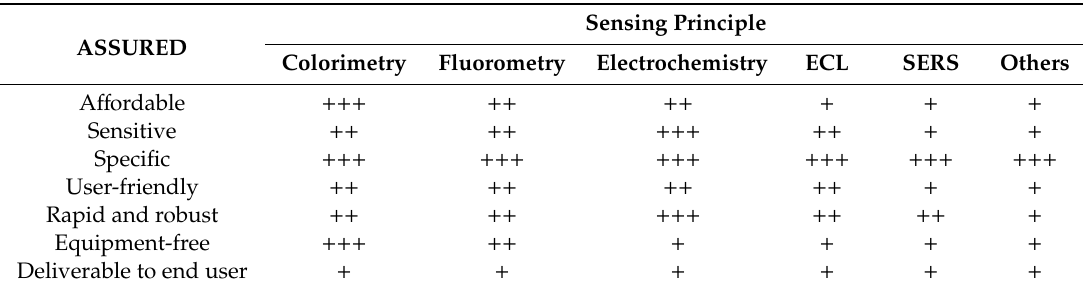
Table 6. Achievement of ASSURED criteria of current pesticide aptasensors represented by three-scale rating. More plus signs ( + ) means higher degree of alignment with the